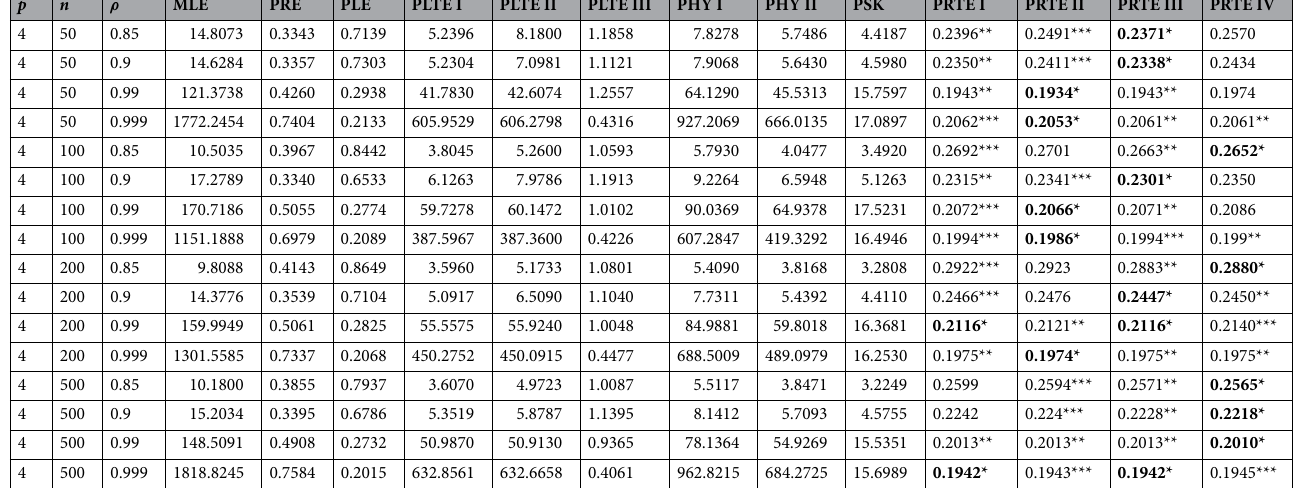
Table 2. The EMSE values of the estimators when p =